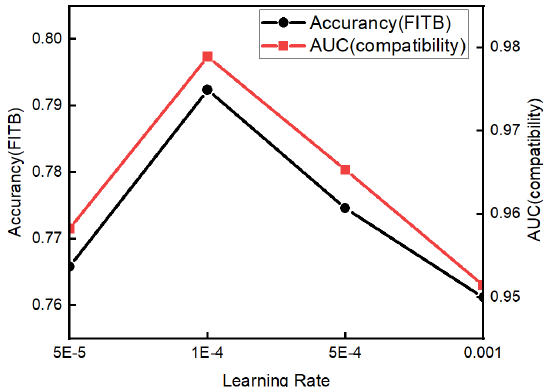
Figure 9. Test performance at different learning